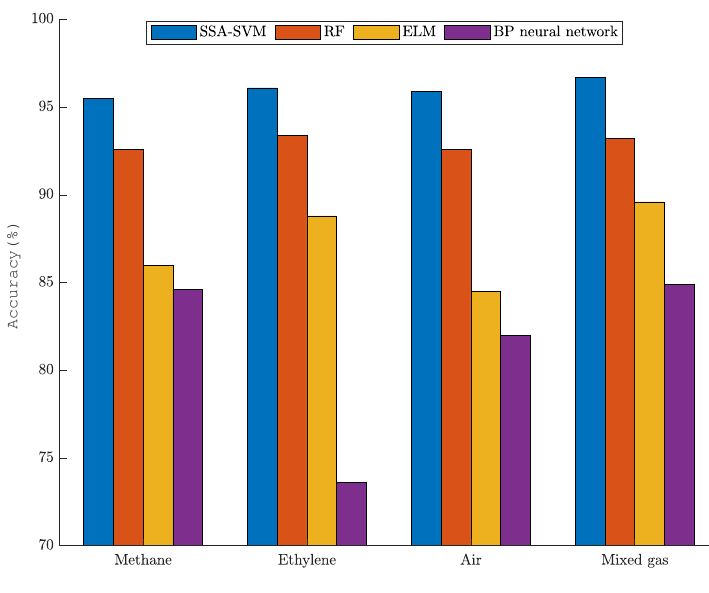
Figure 5. Gas identification accuracy of the four mixed-gas-identification methods.